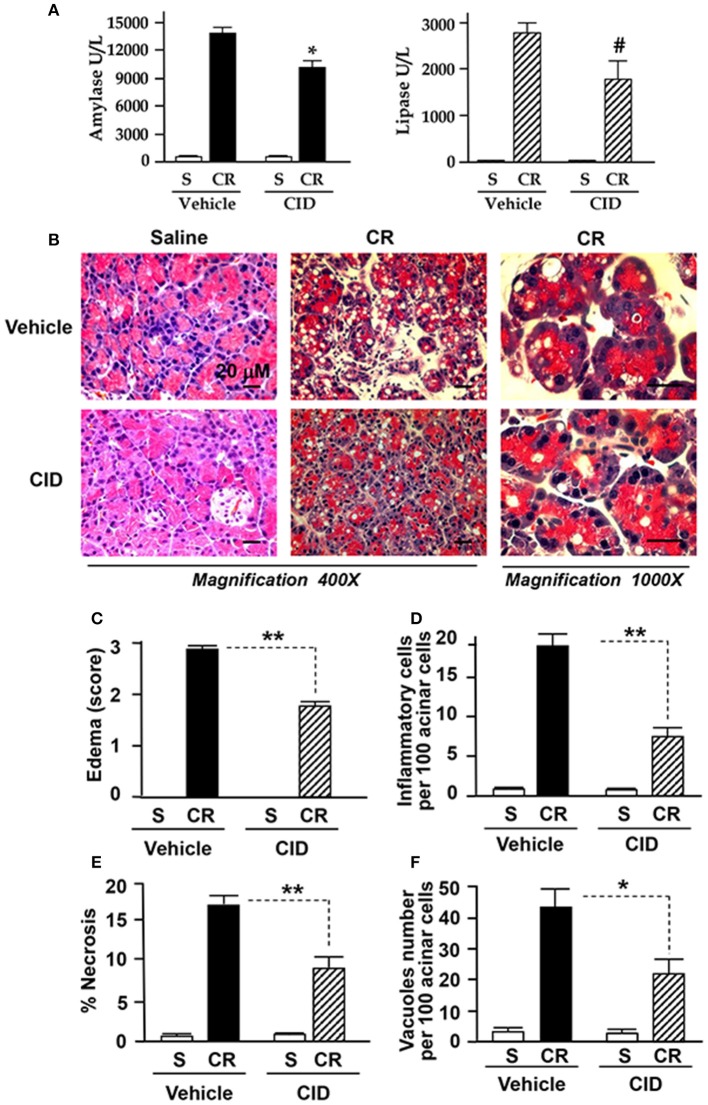
CID755673 post-treatment ameliorated the severity of pancreatitis. (A) Blood amylase and lipase activation was decreased in cerulein-induced rat pancreatitis treated with PKD inhibitor CID755673 (CID, 15 mg/kg). (B) Representative H&E-stained pancreatic sections from rat pancreatitis treated without or with CID 755673 compound. Compared to rats without CID755673 treatment, cerulein (CR) induced pancreatitis was greatly ameliorated in rats treated with CID755673 (CID). Edema (C) and the percentage of inflammatory cell infiltration (D) necrosis (E) and number of vacuoles (F) were measured on H&E stained sections. Values are means ± SE (n > 3). *p < 0.05, **p < 0.01, or #p = 0.054 vs. CR alone without inhibitor pre-treatments.